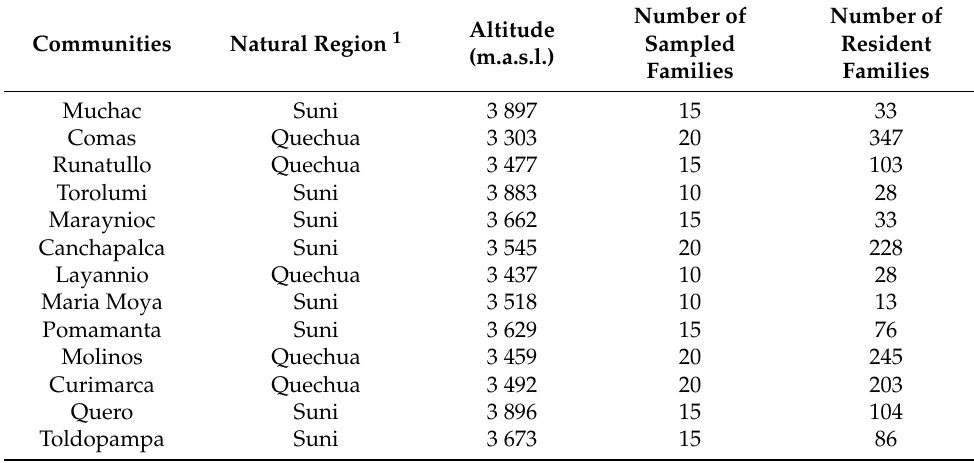
Table 1. Characteristics of the 13 selected rural communities